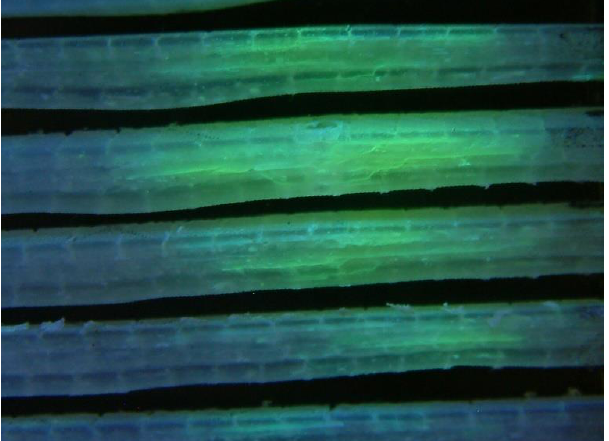
Figure 13. Unmodified panel sections exposed to ultraviolet light impacted at 40 J.